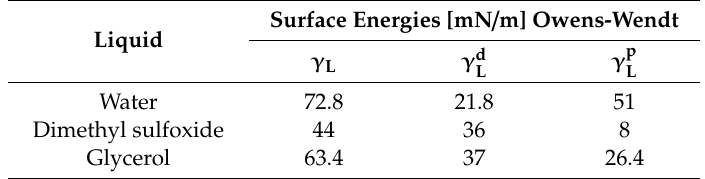
Table 2. Surface tension values of liquids used for contact angle measurements.